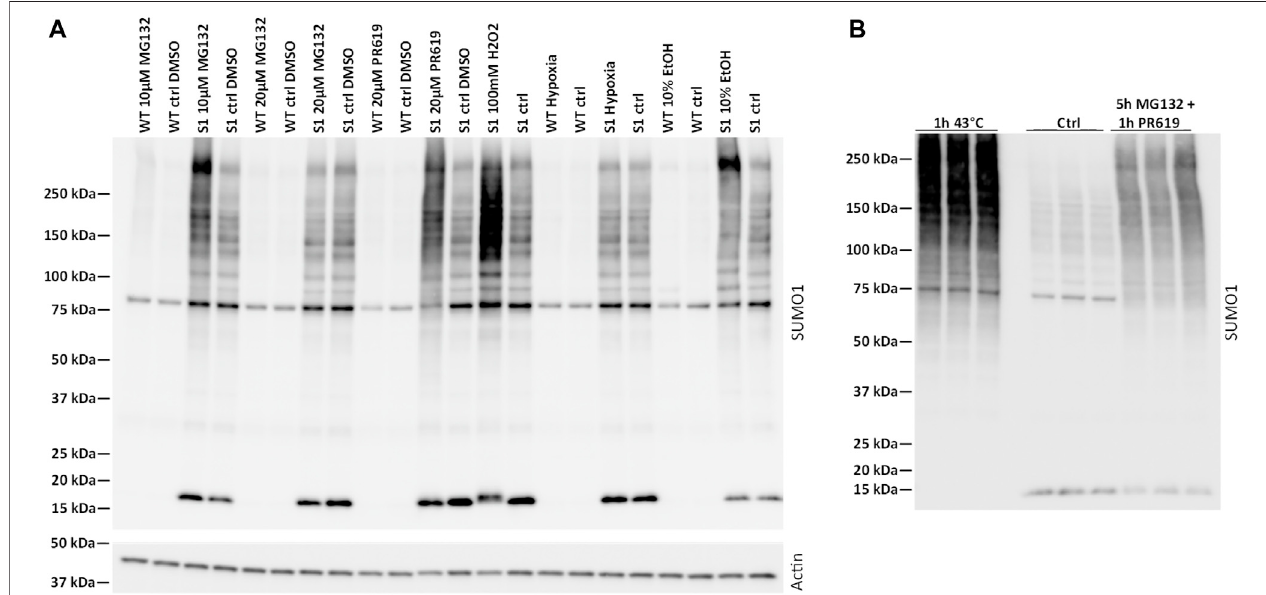
FIGURE 1 | Characterization of SUMOylation in mpkDCT cells. (A) Wild-type (WT) and 6xHis-SUMO1 T95K mutated mpkDCT cells (mpkDCT-SUMO1 T95K ) were treated with various chemicals or pathophysiological conditions known to increase protein SUMOylation. After inhibition of deSUMOylation enzymes with PR619 or MG132, or inducing cell stress with hydrogen peroxide, SUMOylation was increased. Neither 10% ethanol or hypoxia treatment showed any major ability to increase SUMOylated proteins. (B) Heat shock or a mixture of MG132 and PR619 increase SUMOylation in mpkDCT-SUMO1 T95K